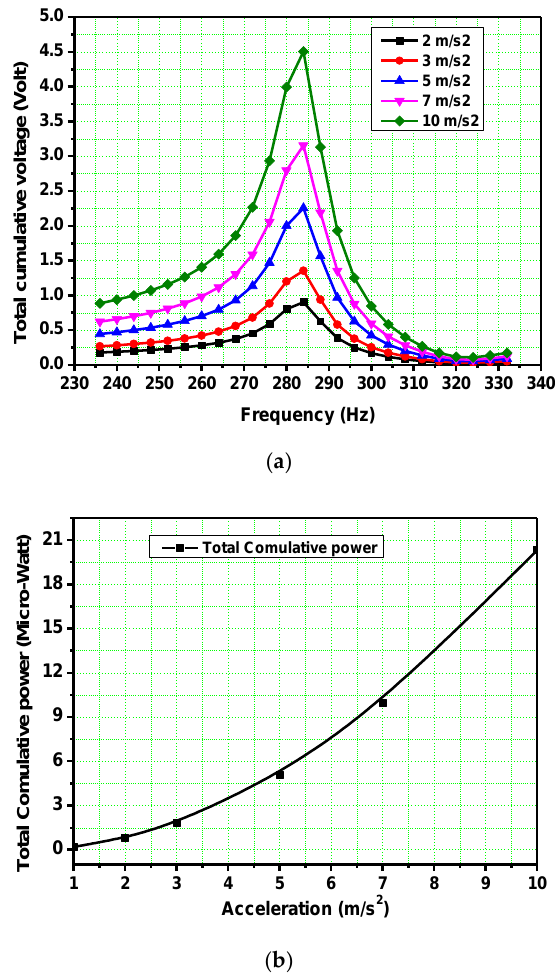
Figure 12. Acceleration effect on: ( a ) total cumulative output voltage and, ( b ) power.